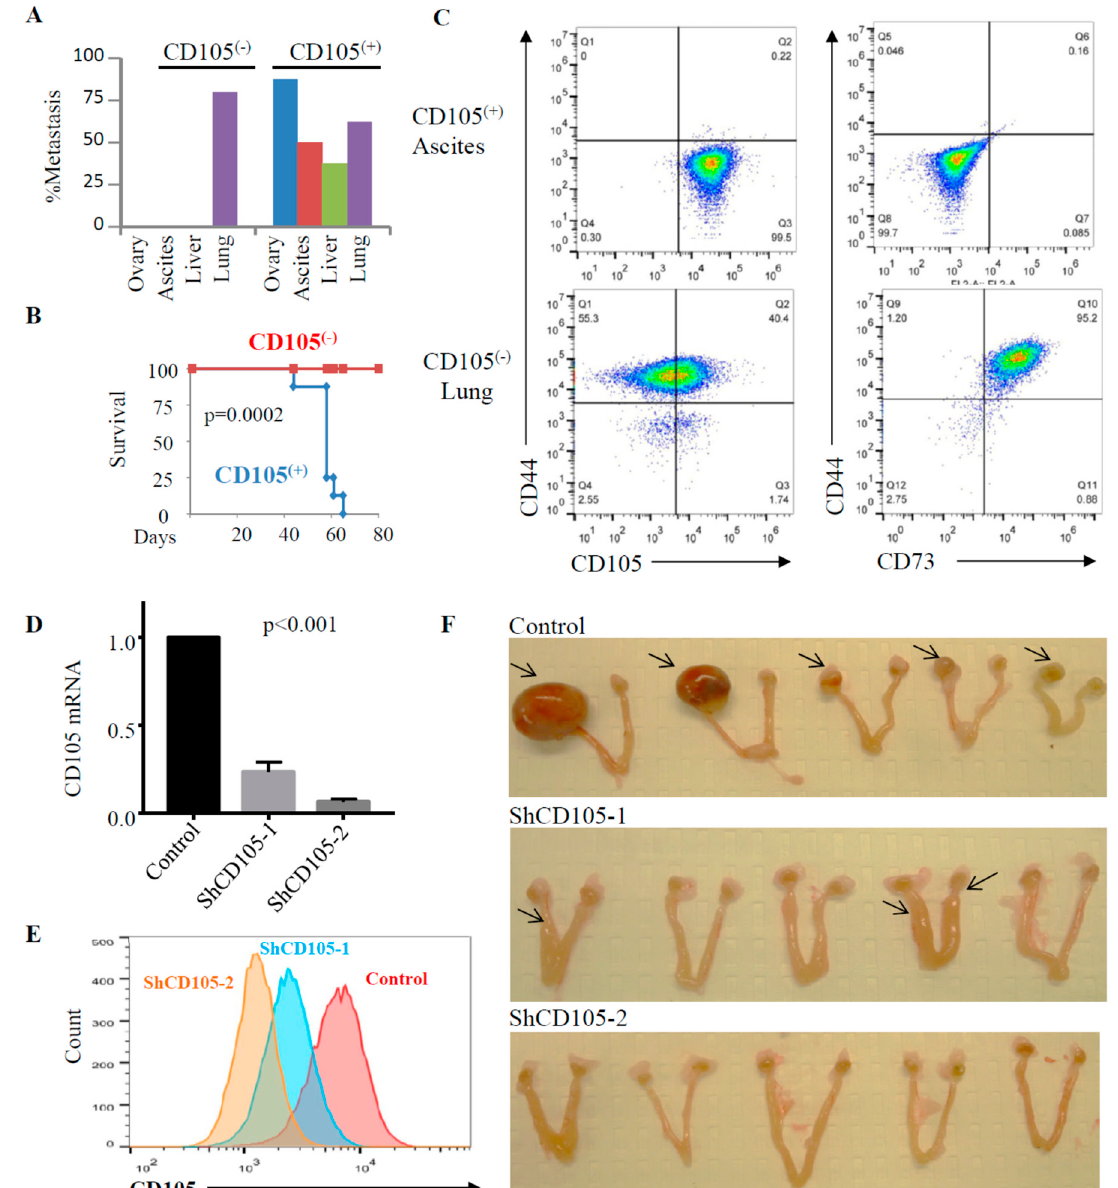
Figure 4. CD105 ( + ) cells, but not CD105 ( − ) cells, metastasized to the ovary hematogenously, which can be prevented by CD105 knockdown in SKOV3 cells. ( A ) Percent of animals developing metastases at the indicated sites from intravenously injected CD105 ( + ) and CD105 ( − ) cells. Metastasis was recorded in the indicated tissues at time of euthanasia. ( B ) Kaplan–Meier survival curves of mice injected by IV with CD105 ( − ) or CD105 ( + ) SKOV3 tumor cells ( n = 5 / group for CD105 ( − ) , n = 8 / group for CD105 ( + ) ). ( C ) Flow cytometric analysis of expression of the indicated cell markers of CD105 ( + ) cell-derived metastatic ascites and CD015 ( − ) cell-derived lung tumors. ( D , E ) CD105 knockdown eliminates hematogenous ovarian metastasis of SKOV3 cells. ( D ) qRT-PCR evaluation of CD105 mRNA expression in scrambled shRNA control and CD105 shRNA knockdown cells in FACS-sorted CD105 ( + ) SKOV3 cells. The level of CD105 in control cells is defined as 1 after normalization with HPRT. The values are the means ± SD from three independent experiments ( p < 0.001). ( E ) Flow cytometric analysis of CD105 protein expression in scrambled shRNA control, shCD105-1, and shCD105-2 in FACS-sorted CD105 ( + ) SKOV3 cells. ( F ) Images of ovaries and uterine horn metastasis in the indicated control and CD105-knockdown cell lines ( n = 5 each). Mice were sacrificed 4 weeks after cell